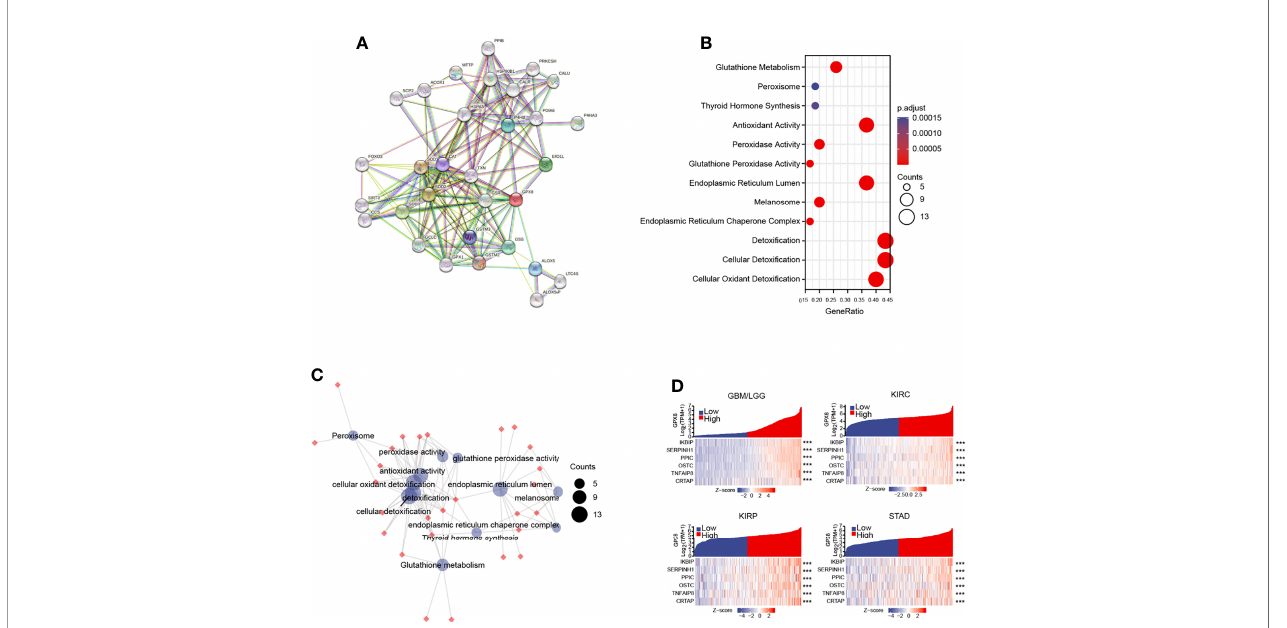
FIGURE 7 | The analysis of GPX8 and GPX8-related partners. (A) The GPX8-binding PPI analysis of GPX8. (https://string-db.org/, http://gepia.cancer-pku.cn/index. html). (B) The GO and KEGG analysis of GPX8 and GPX8-related partners. (https://www.kegg.jp/). (C) The relationship of pathways. (D) The co-expression analysis of GPX8 and GPX8-related genes in GBM/LGG, KIRC, KIRP and STAD. (https://portal.gdc.cancer.gov/). ***P < 0.001.